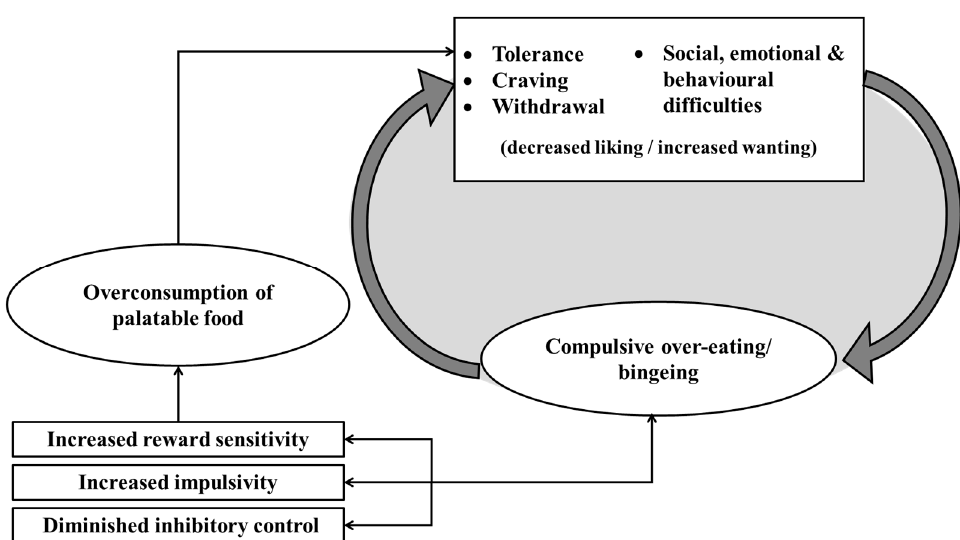
Figure 1. The proposed cycle of ‘food addiction’. Initial vulnerability for the over-consumption of palatable food is marked by increased impulsivity and reward sensitivity, as well as a diminished capacity for inhibitory control. As a consequence of overconsumption, individuals experience tolerance, craving and withdrawal, along with a range of social, emotional and behavioural difficulties such as weight stigmatisation and feelings of guilt and shame. With repeated consumption of these foods, the individual is likely to habituate to the hedonic properties of the food, resulting in reduced enjoyment or liking. These changes are also accompanied by an increased desire or ‘wanting’ for the food [104–108]. In an attempt to relieve these symptoms, the individual ‘self-medicates’ by increasing food consumption, which can result in compulsive or binge eating behaviour, thus creating a cycle of addiction. It should be noted that the extent to which each of these mechanisms is experienced varies considerably across individuals. In particular, initial vulnerability to addiction may be related to individual differences in reward sensitivity, impulsivity and inhibitory control [110–113].